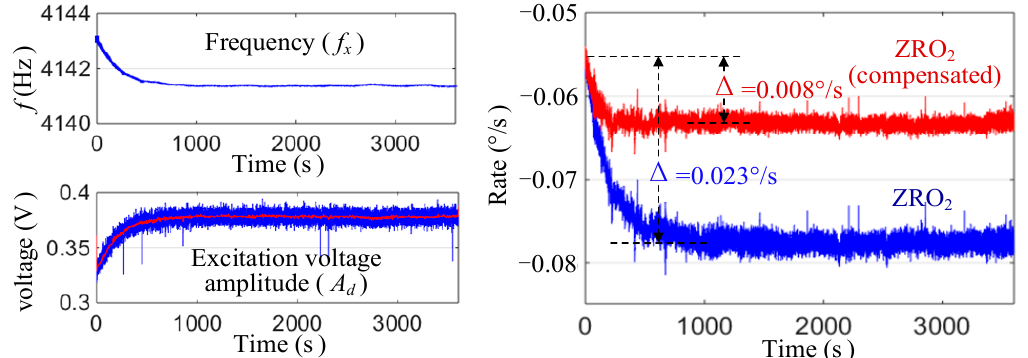
Figure 12. Online compensation process for ZRO 2 during the power-on